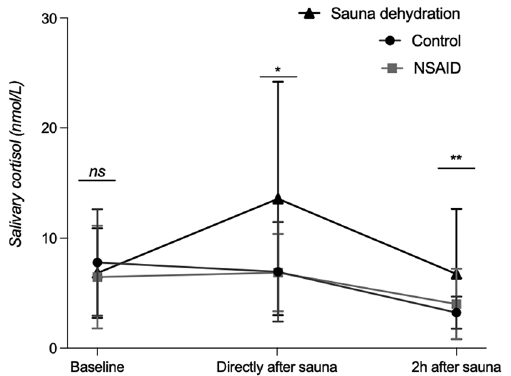
Figure 6. Salivary cortisol concentrations over time during the different test conditions. Saliva samples at the control and NSAID visit were collected at similar times of the day as during the sauna condition in order to consider diurnal changes. Median and IQR are shown. p-values indicate significant differences between the control and sauna dehydration condition. * P < 0.05 (sauna dehydration versus control). ** P < 0.01 (sauna dehydration versus control). ns, non-significant. NSAID, nonsteroidal anti-inflammatory